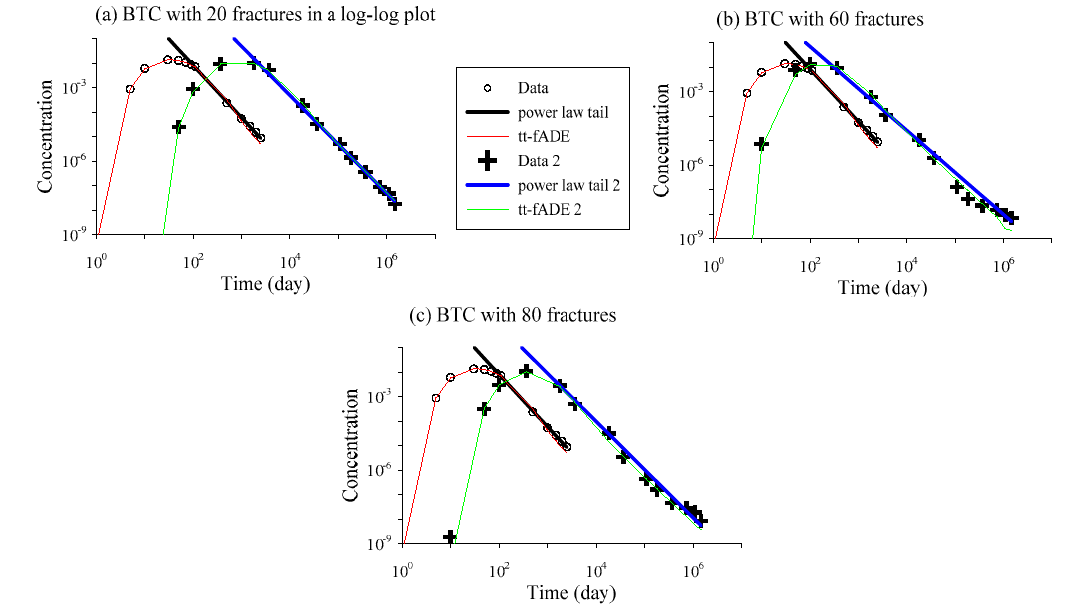
Figure 3. BTCs at the control plane x = 50 m for three different fracture densities ( a – c ) with matrix permeability of 1.1 × 10 − 13 m 2 (red lines and circles) and 5.5 × 10 − 15 m 2 (green lines and crosses). The BTC data (i.e., symbols) are simulated by HGS. The red/green line is the solution of the tt-fADE model (10) and (11). The black/blue line is a power-law approximation to the late time decay in concentration.